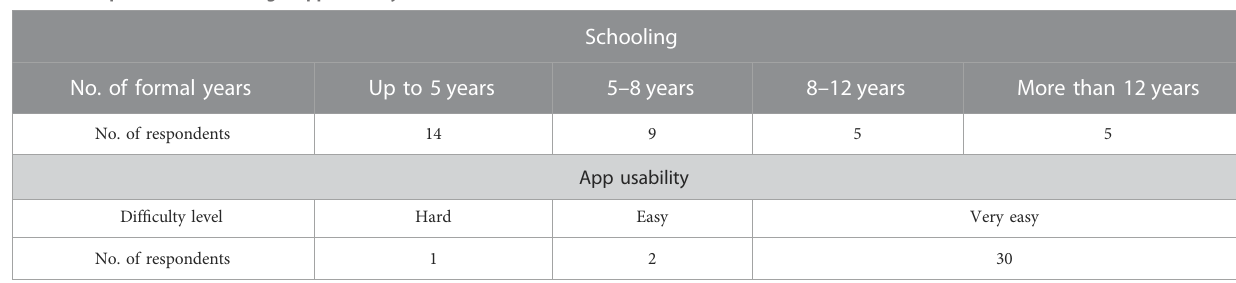
TABLE 2 Respondents ’ “ schooling x app usability ”